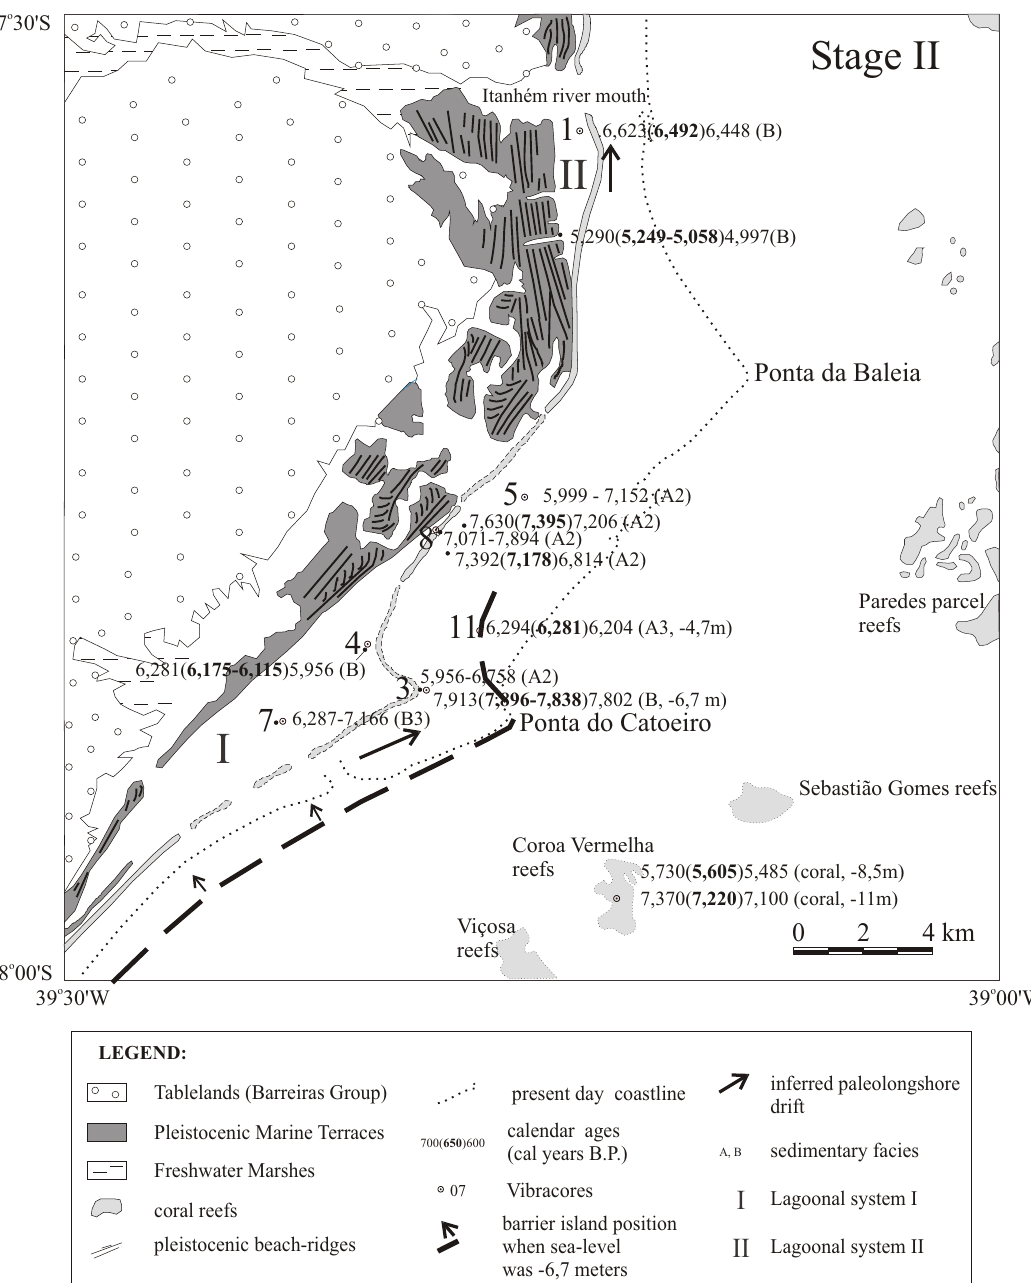
An Acad Bras Cienc (2003) 75